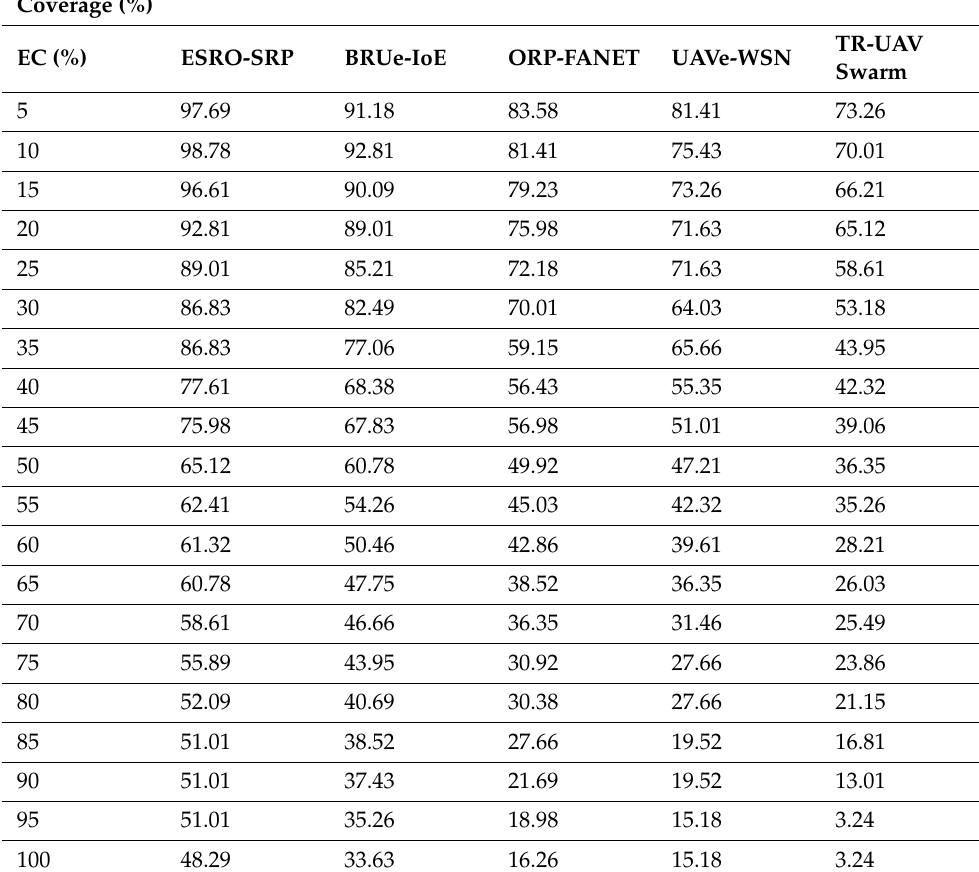
Table 4. Coverage analysis of ESRO-SRP technique with existing algorithms under distinct levels of